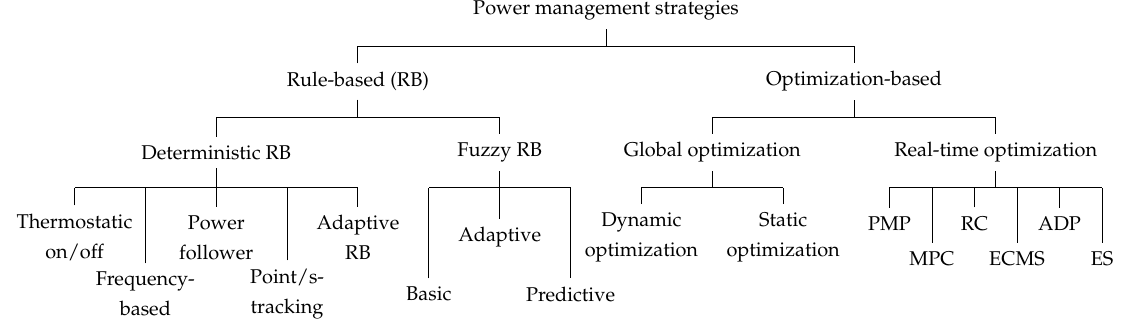
Figure 2. Classification of power management